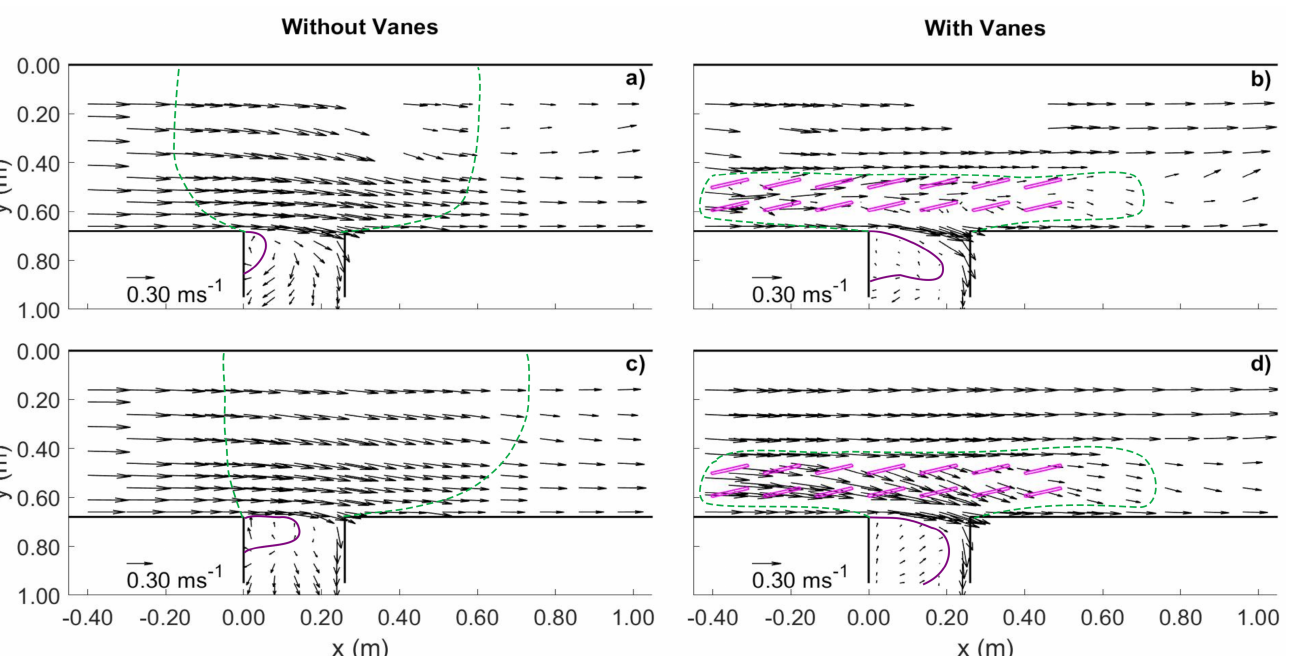
Figure 9. Direction and magnitude of the velocity components ( u , v ) (ms − 1 ) as vector arrows, in the NV and the VF experiments, at horizontal plans: ( a ) z = 0.017 m. ( b ) z = 0.015 m. ( c ) z = 0.062 m. ( d ) z = 0.065 m. Plans ( a , b ) are defined ≈ 0.01 m below the top of the vanes; plans ( c , d ) are ≈ 0.035 m above the top of the